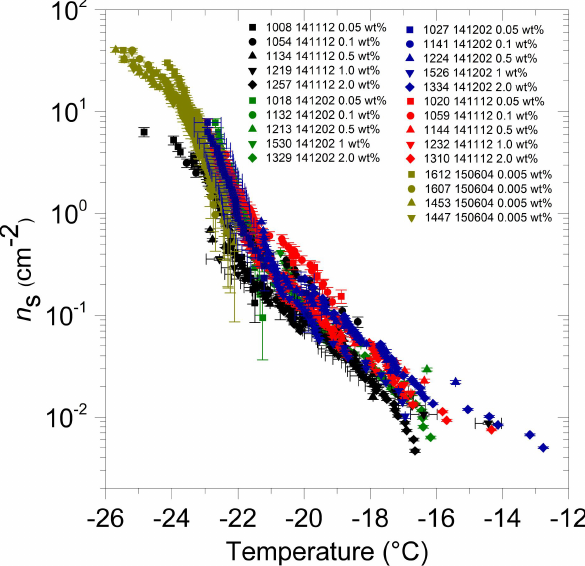
Figure 9. n s values for NX-illite determined from experiments with suspensions of a range of concentrations. Y-error bars have been calculated using the background subtraction method described in O’Sullivan et al. (2015), which includes the error propagation described in Sect. 2.1. X-error bars are included on certain data sets to facilitate comparison. 0.05 to 2wt% suspensions were made gravimetrically, the 0.005wt% suspensions were made by diluting 0.5wt%